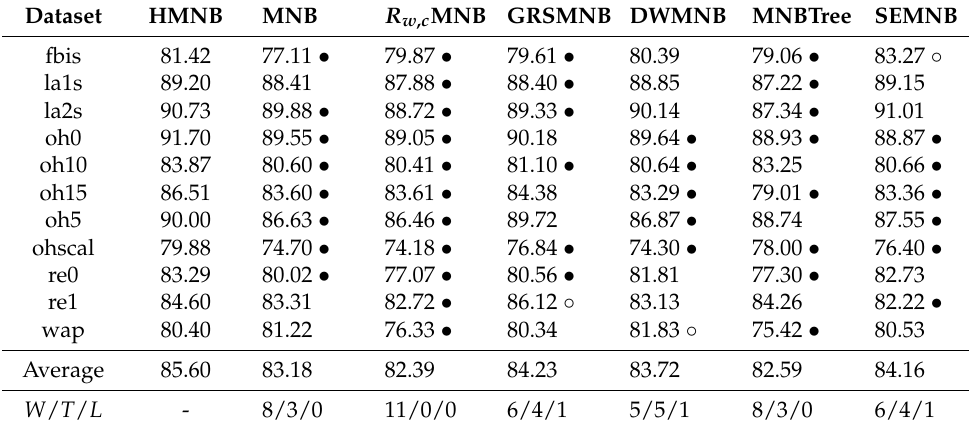
Table 2. Comparisons of the classification accuracy for HMNB versus MNB, R w , c MNB, GRSMNB, DWMNB, MNBTree, and SEMNB.